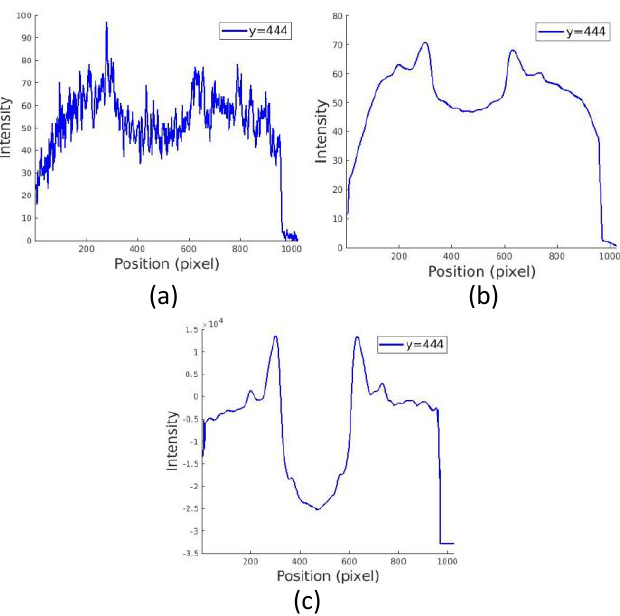
Fig. 3. Intensity profiles across the width of the phantom 2 images presented in Fig. 2b-c. The intensity signals correspond to images of the phantom (a) prior to denoising, (b) after denoising, and (c) after denoising and log-flat field